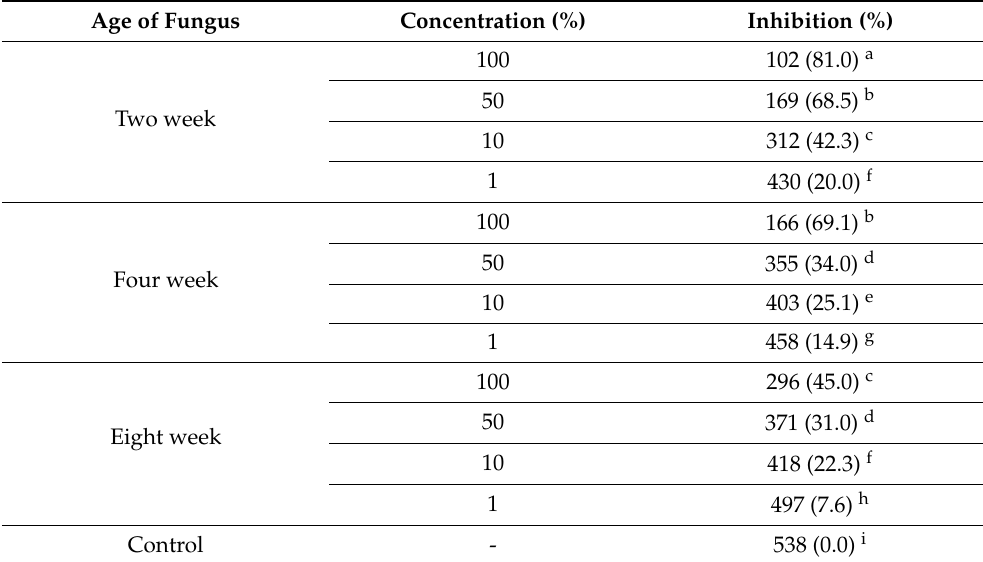
Table 2. Effect of different stages of stipe of Ganoderma lucidum on egg hatching inhibition of root-knot nematode, Meloidogyne incognita .